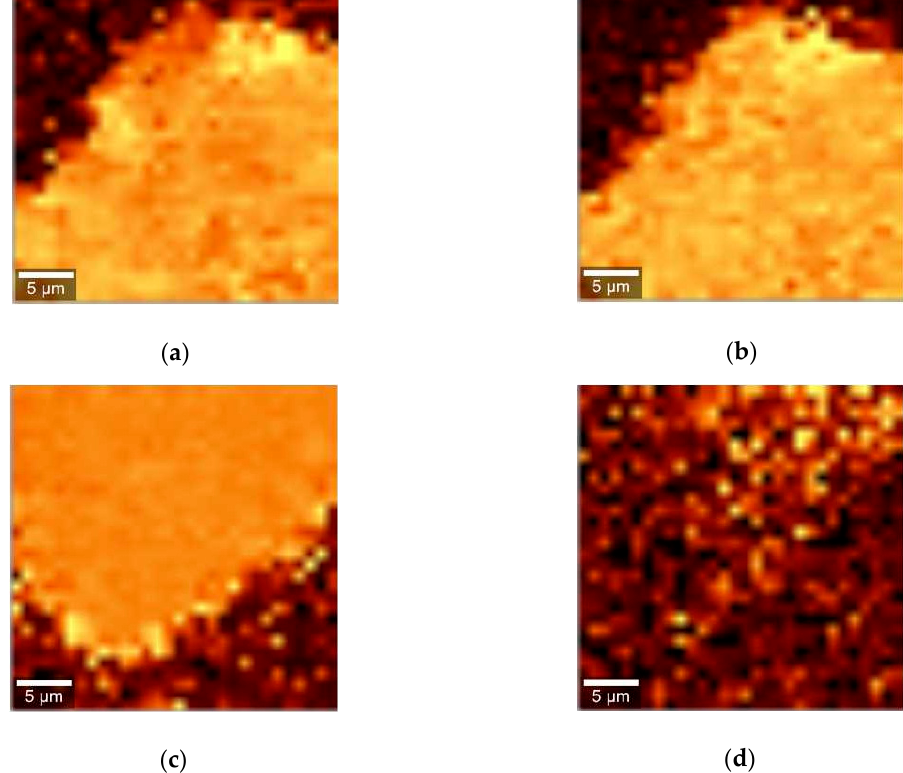
Figure 4. Distribution of Raman peaks at 1182 cm -1 and 1252 cm -1 in the particles present in the cream (( a ) and ( b ), respectively) and gel (( c ) and ( d ), respectively), represented in false colors. Irradiation of the formulations with the blue light of the same wavelength and intensity for the same amount of time as used in PDT treatment in the absence of the nail showed that curcumin is not bleached substantially. Both cream and gel showed presence of the curcumin particles after illumination, and the spectra of the particles remained unchanged (Figure 5).